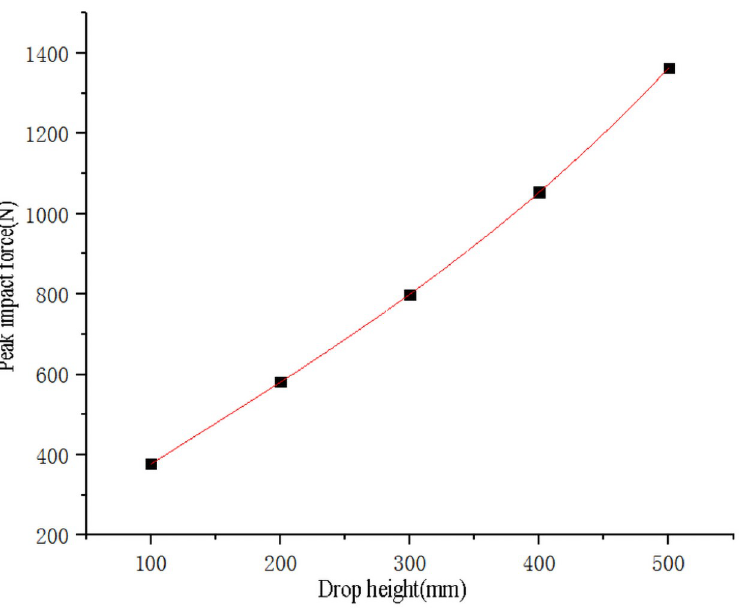
Fig 10. Fitting curve of sweet potato drop height and impact force peak